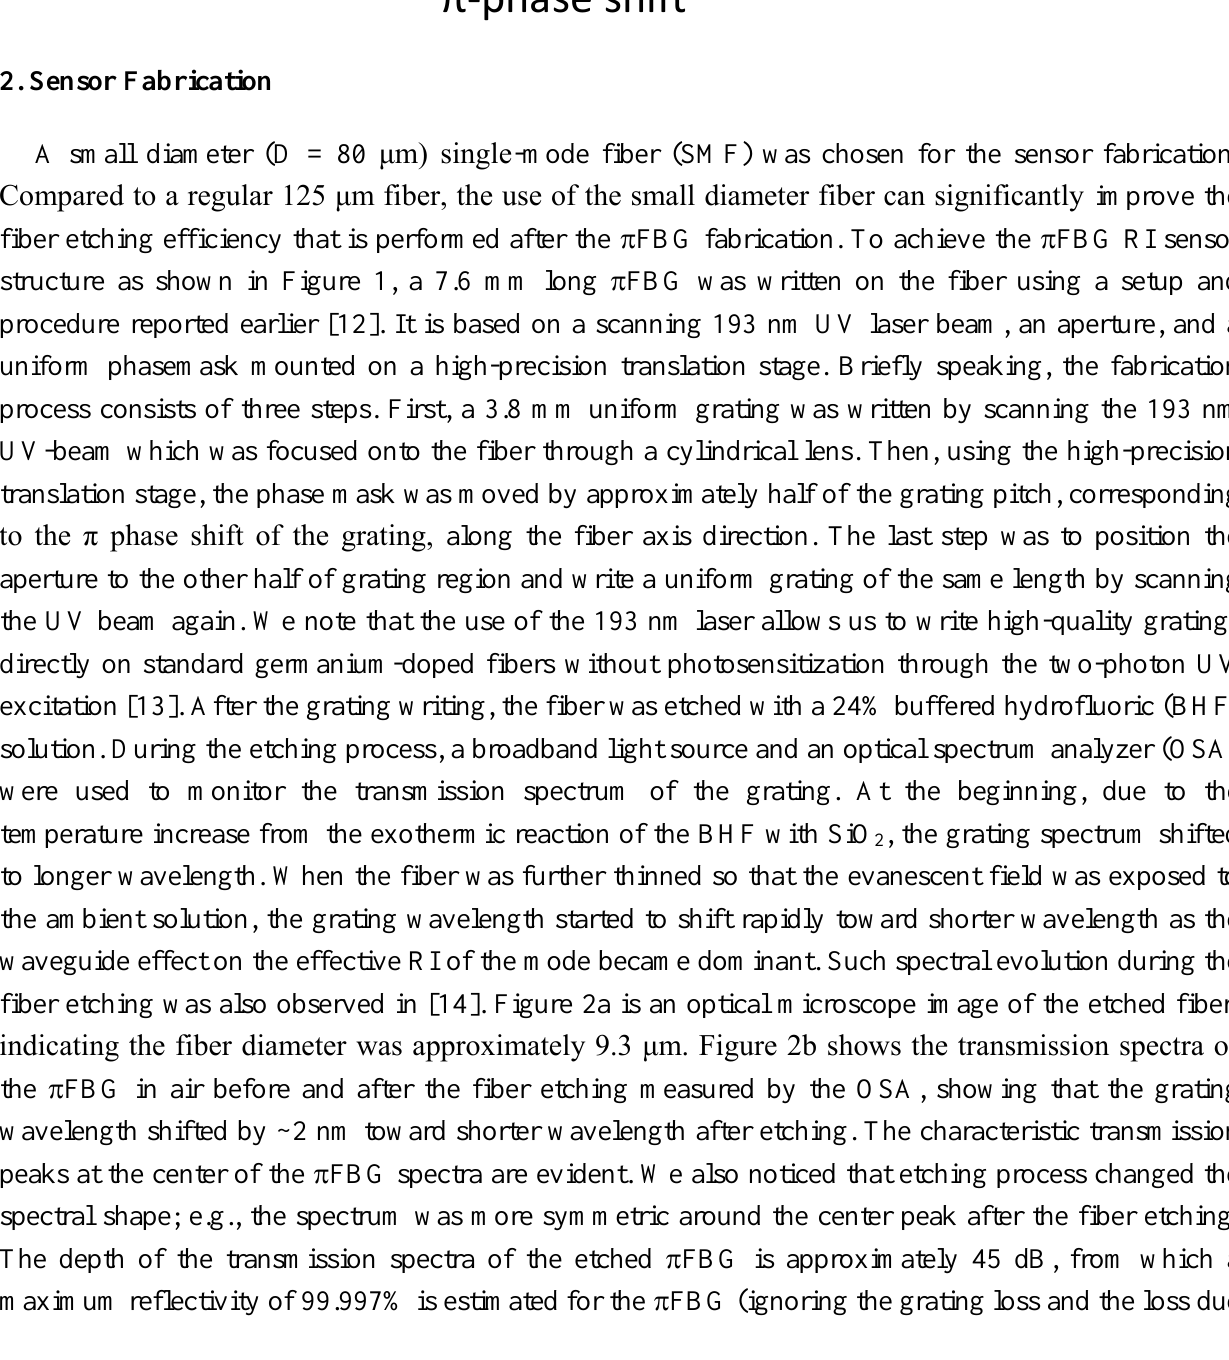
Figure 1. Schematic of a  FBG RI